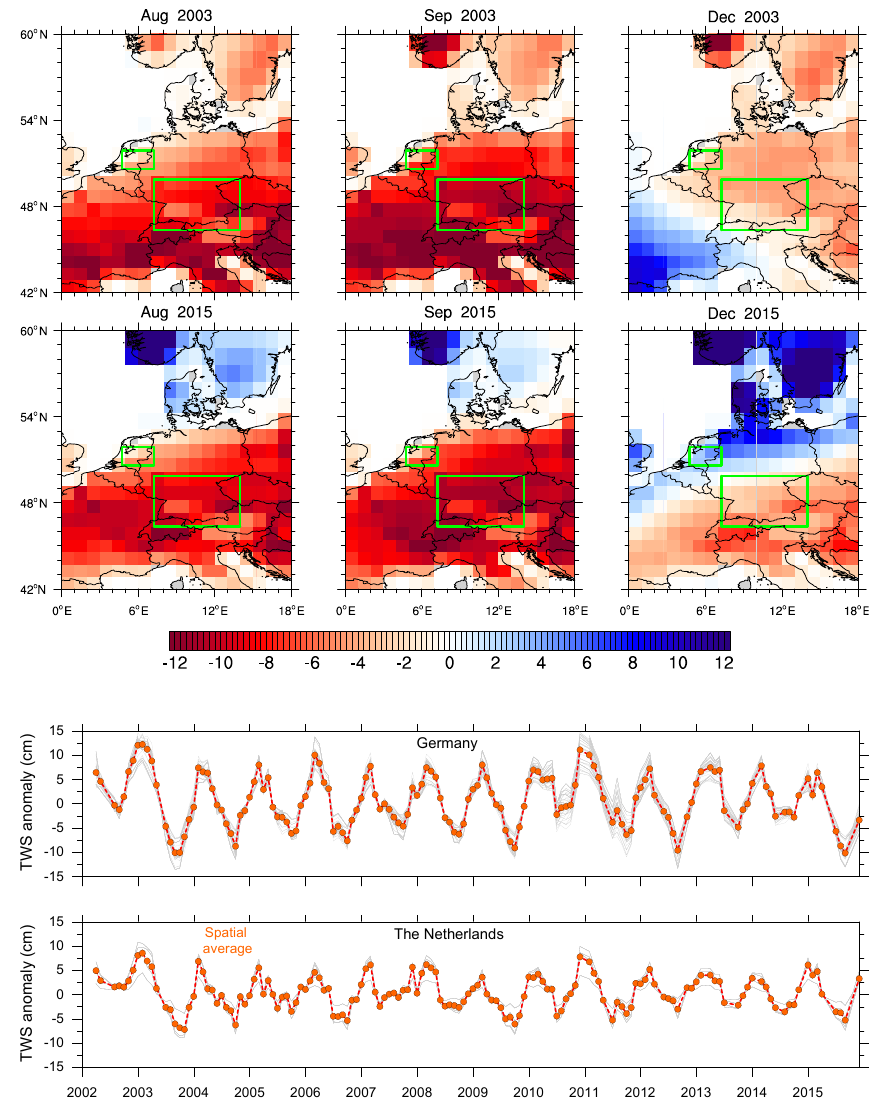
Figure 3. The GRACE-derived terrestrial water storage (TWS) anomalies (cm) for the available 3 common months (August, September, and December) during the 2003 and 2015 drought events (top panels). The bottom two panels depict the monthly TWS anomalies for every grid cell located within the study domains (shown in the green boxes in the top panels: south Germany and central Netherlands) as well as their spatial